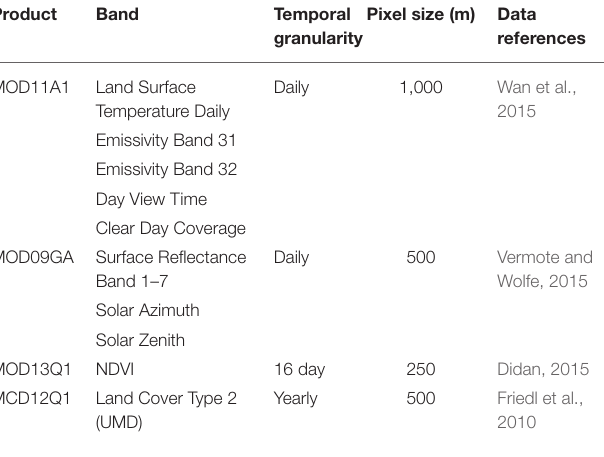
TABLE 2 | Moderate-Resolution Imaging Spectroradiometer (MODIS) products and bands used for SEBAL